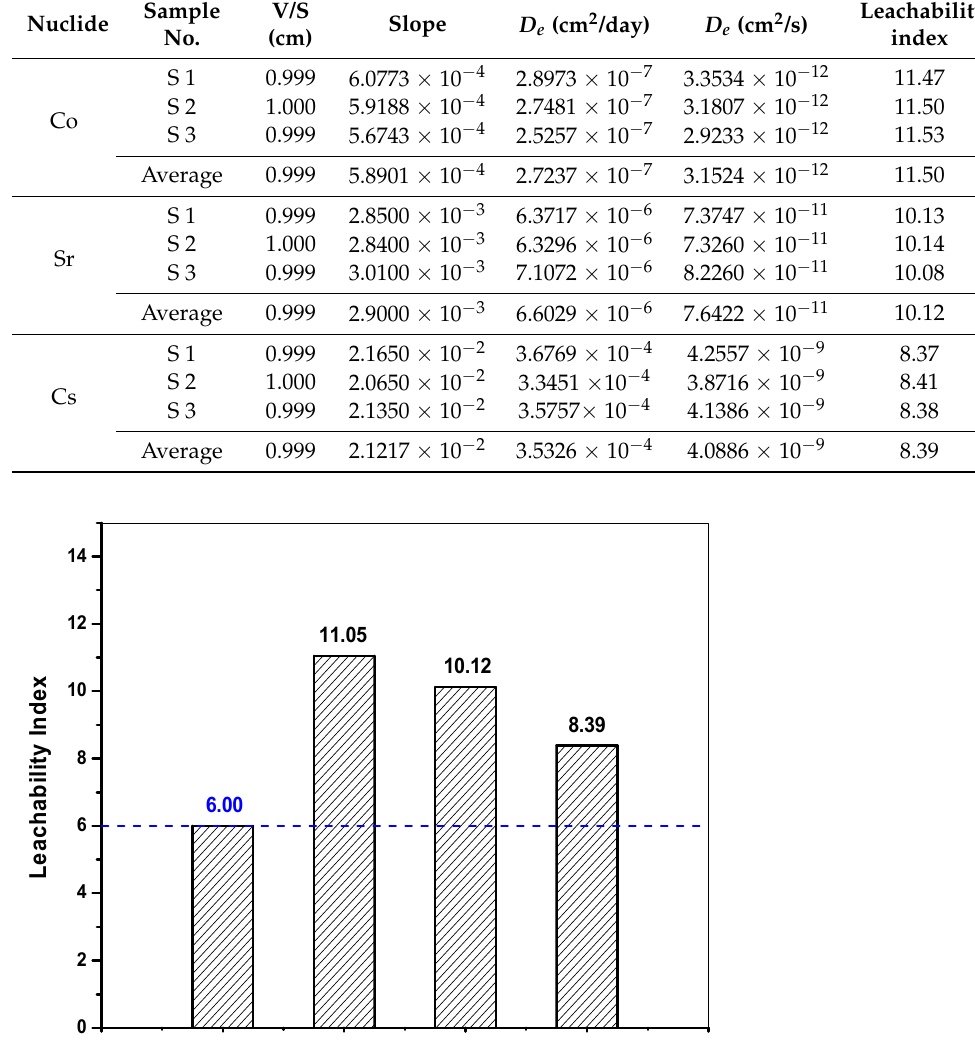
Table 11. Effective diffusion coefficient and leaching indexes for each nuclide (Cs, Sr, and Co).